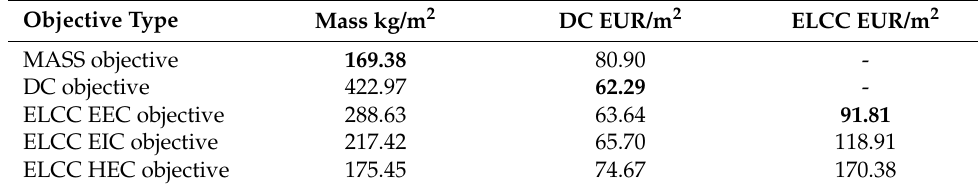
Table 2. The optimal